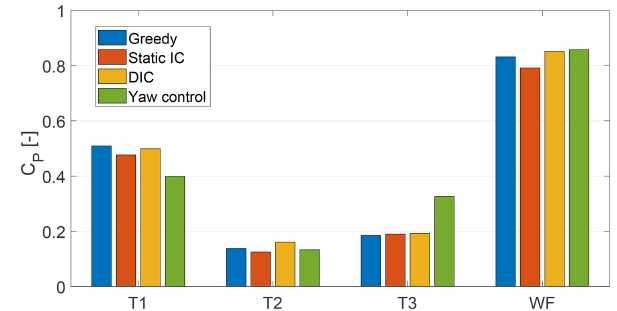
Figure 14. The power capture of three state-of-the-art control ap- proaches compared with periodic DIC in low-TI conditions. The power capture of the three individual turbines (T1–3), as well the total wind farm (WF) is